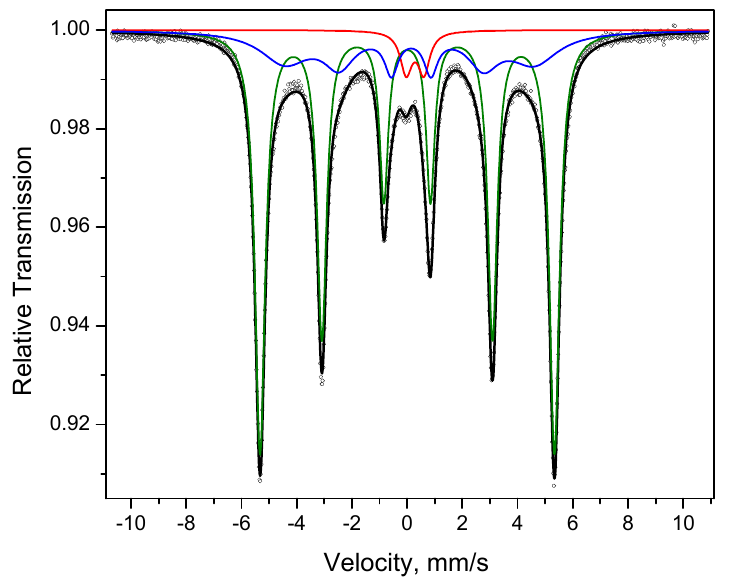
Figure 6. Mössbauer spectrum of the Fe@Pd core–shell particles obtained by galvanic replacement reaction: dots—experimental data, black line—spectrum represented as a superposition of two sextets (green and blue lines) and a doublet (red line).